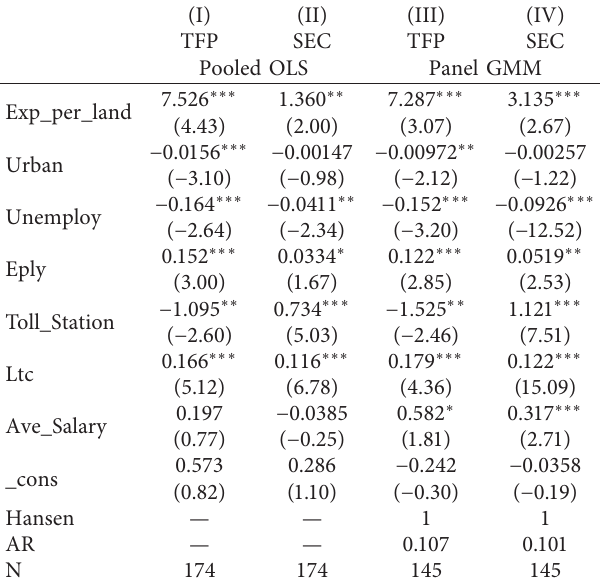
Table 5: Robustness test